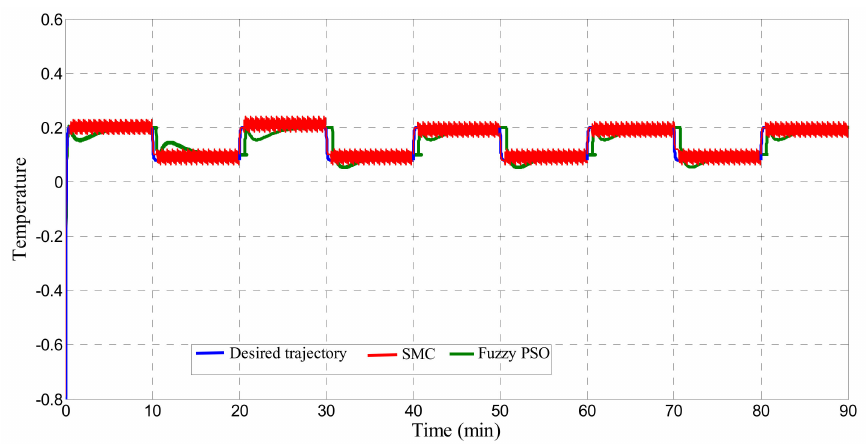
Figure 14. Output trajectory